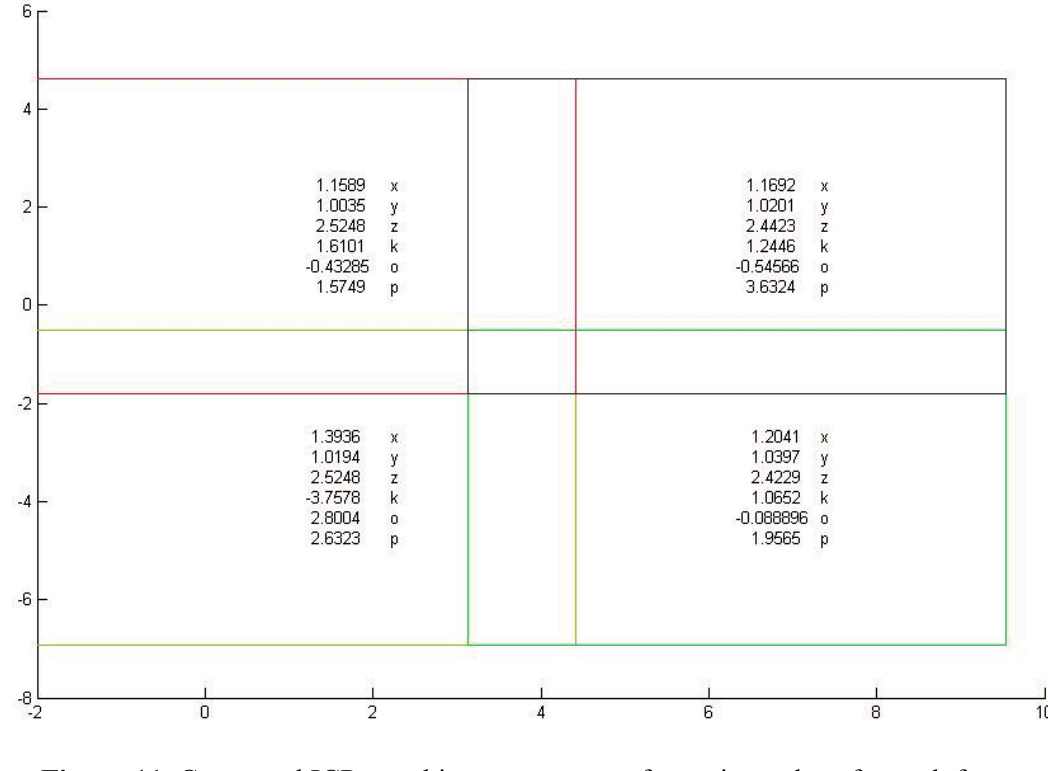
Figure 11. Computed ICP matching process transformation values for each